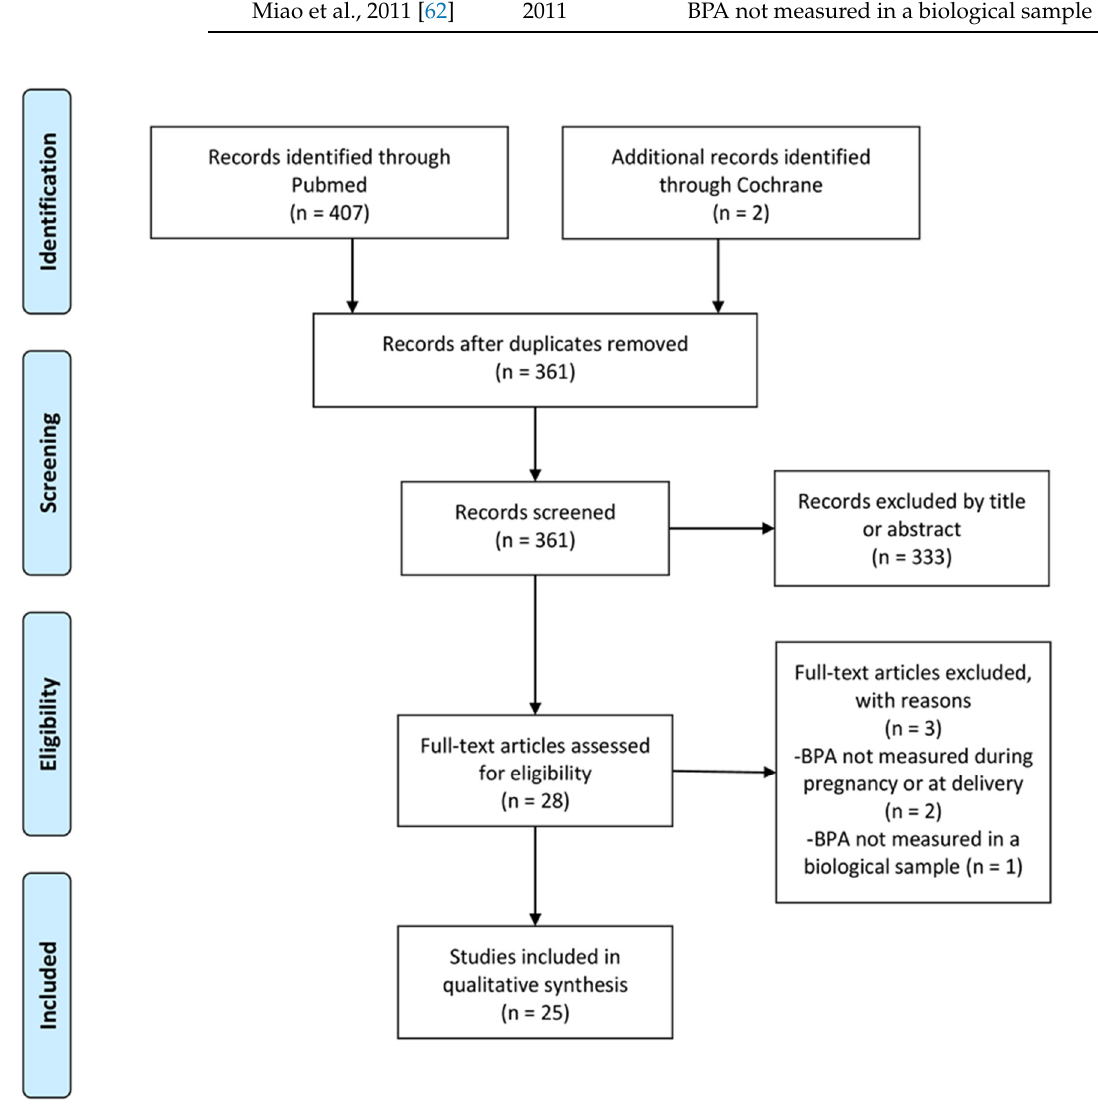
Figure 2. Prisma flow diagram of the selection process.